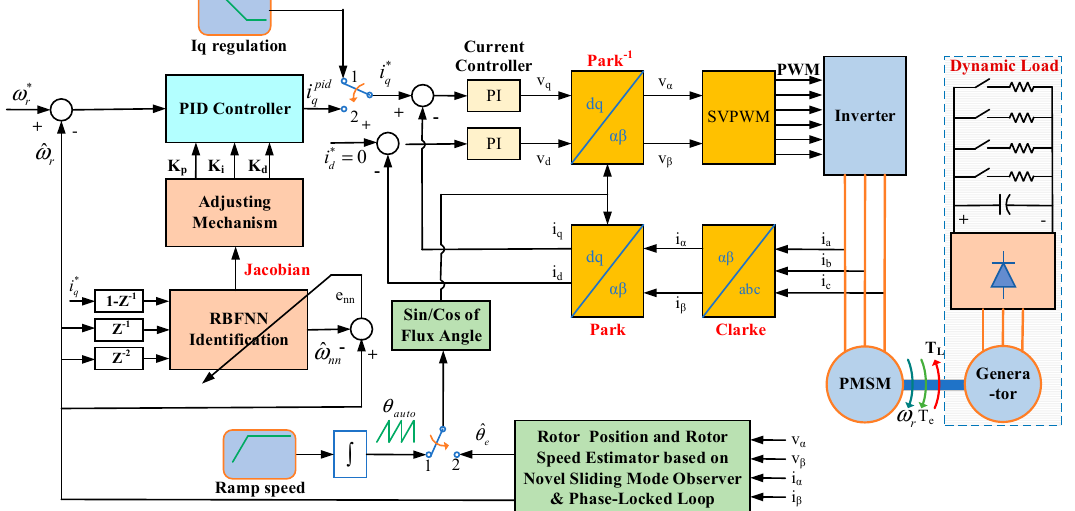
Figure 1. The architecture of a self-tuning PID (Proportional-Integral-Derivative) speed controller based on the radial basis function neural network (RBFNN) for the sensorless permanent magnet synchronous motor (PMSM) drive control system with the dynamic load.